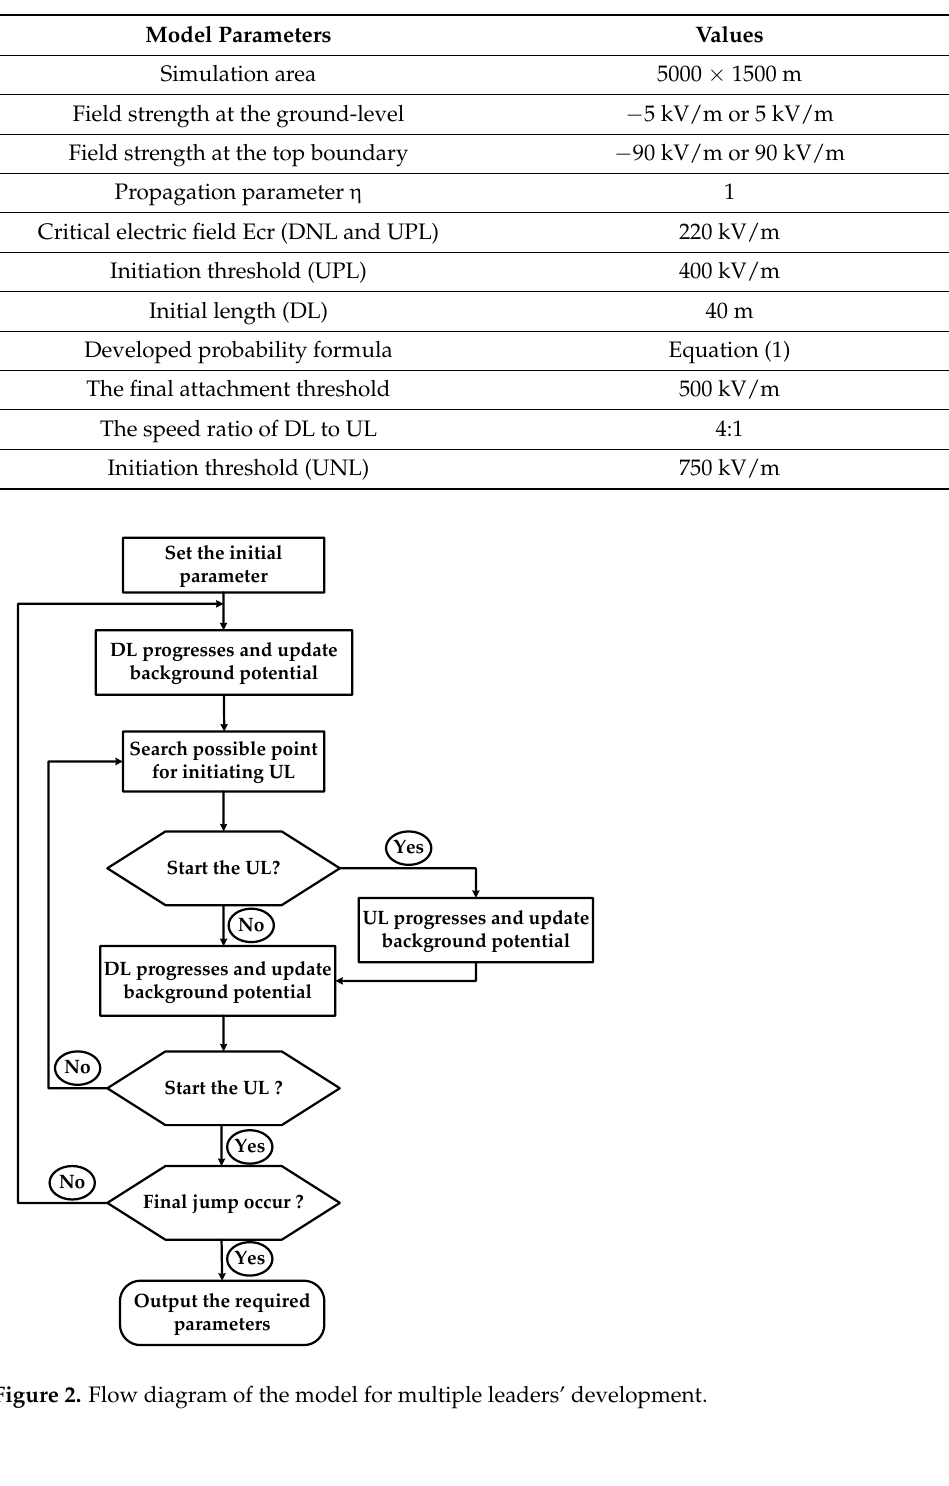
Table 1. Model parameters.